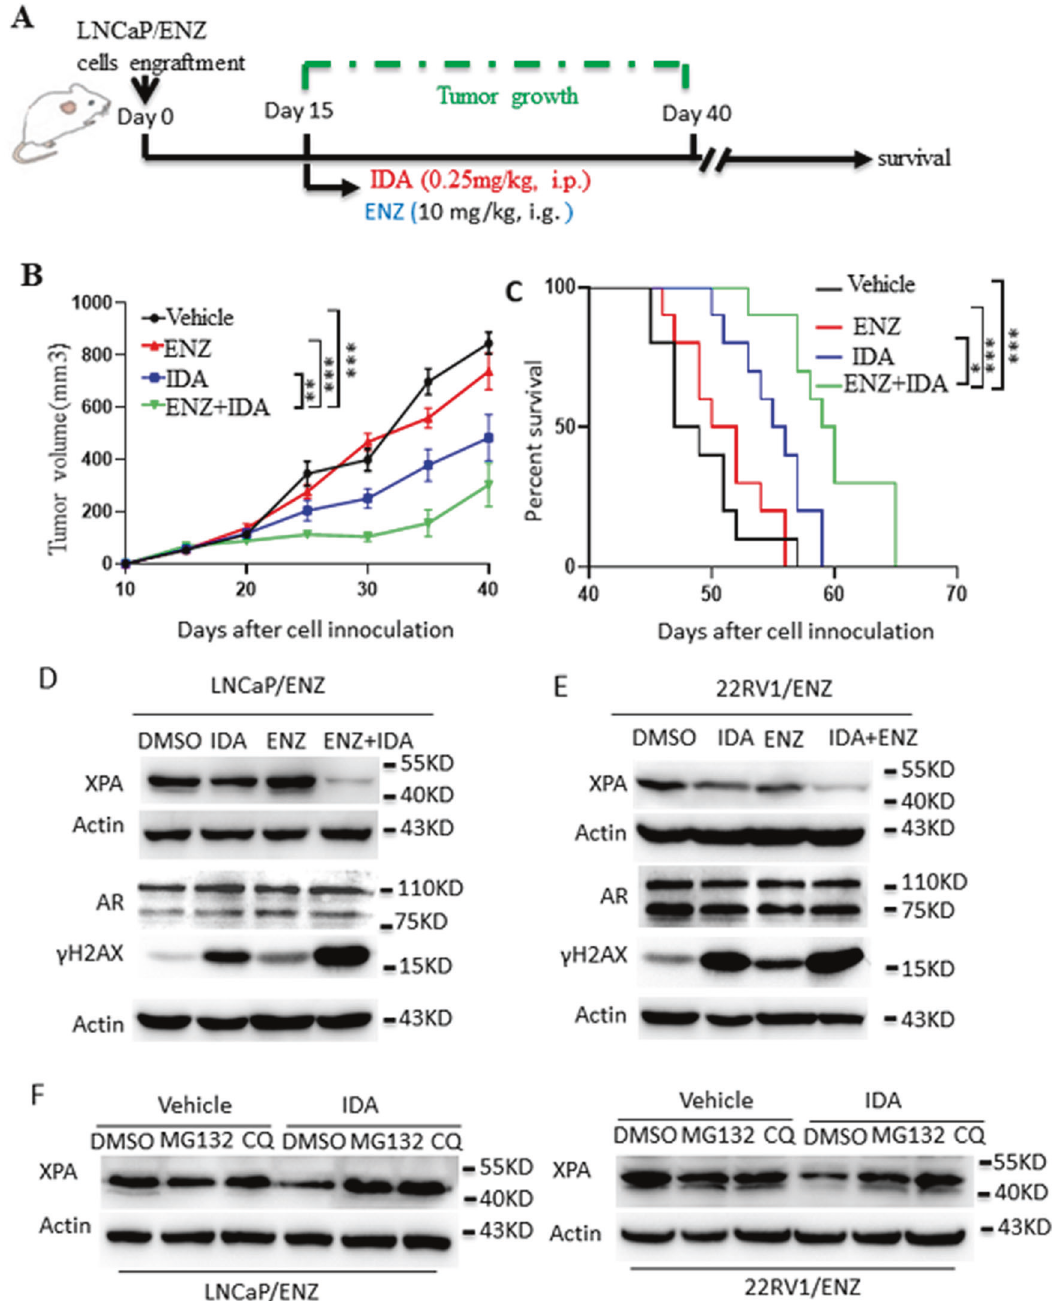
Fig. 5 IDA/XPA also combats enzalutamide resistance in prostate cancer cells. A – C LNCaP/ENZ cells were injected subcutaneously into the fl anks of 8-week-old castrated male null mice. When tumor sizes reached ~50 mm 3 , mice were administered with the vehicle (10% DMSO plus 90% corn oil mixture as control, n = 10), IDA (0.25 mg/kg, i.p.), EZN (10 mg/kg, i.g.), and combination EZN (10 mg/kg) and IDA (0.25 mg/kg) ( A ). Tumor volume ( B ) and survival ( n = 10, per group) ( C ) were monitored as indicated days. D , E LNCaP/ENZ ( D ) and 22RV1/ENZ(E) cells were treated with DMSO, IDA(0.25 μ M), ENZ(10 μ M), and a combination of ENZ with IDA for 24 h. XPA protein levels, γ H2AX, and AR were determined by western blot. F. LNCaP/ENZ and 22RV1/ENZ cells were treated with DMSO, MG132(1 μ M), and CQ(30 μ M) with or without IDA(0.25 μ M) for 24 h. XPA protein levels were determined by western blot. Data are presented as means ± s.e.m. Statistical analysis for tumor growth and overall animal survival were performed using two-way ANOVA analysis ( B ) and Log-rank (Mantel – Cox) test analysis ( C ), respectively. The asterisks indicate signi fi cant differences between the indicated groups (* p < 0.05, *** p <